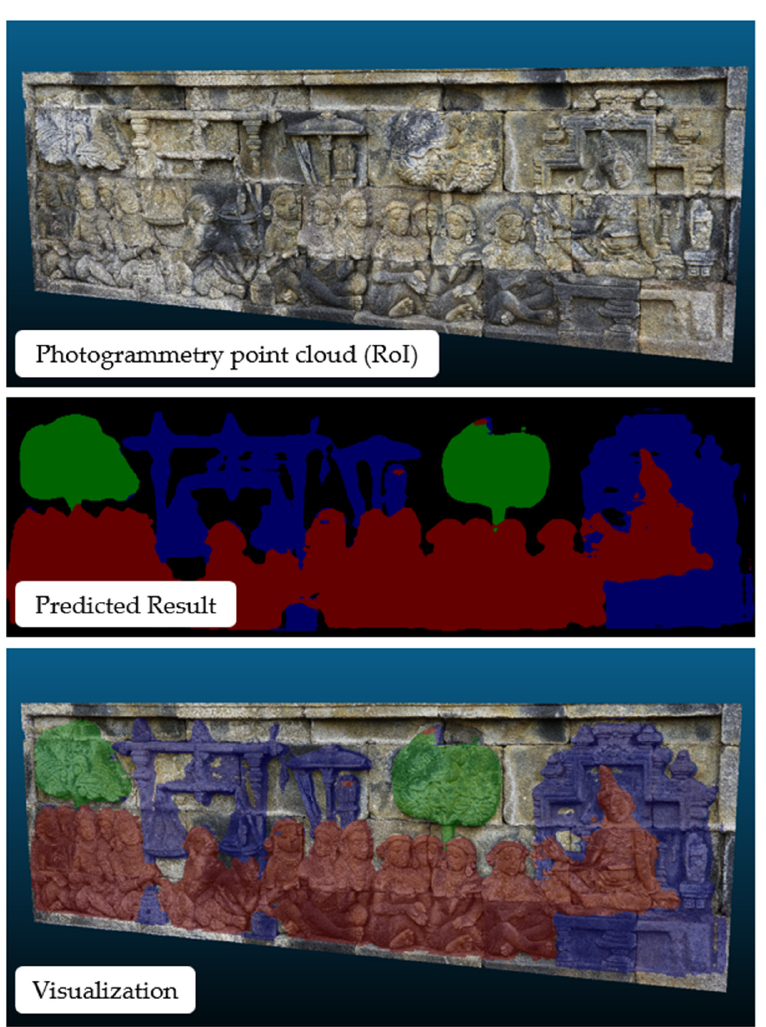
Figure 12. Visualization results of mapping two-dimensional prediction results to three-dimensional point cloud.